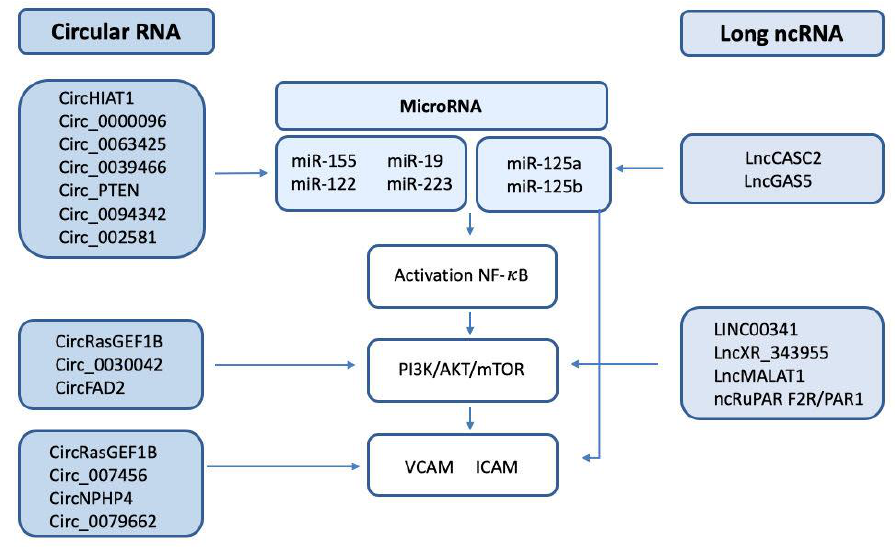
Figure 3. Scheme of the circRNA/lncRNA/miRNA involved in the regulation of NF- κB, the PI3K/AKT/mTOR pathway, and the endothelial adhesion factors VCAM and ICAM.